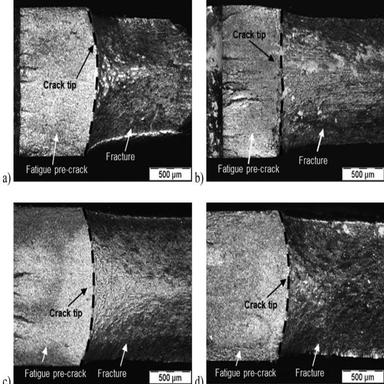
Fracture surface of DENT specimens: (a) CP (b) DP (c) TBF (d) Q&P.